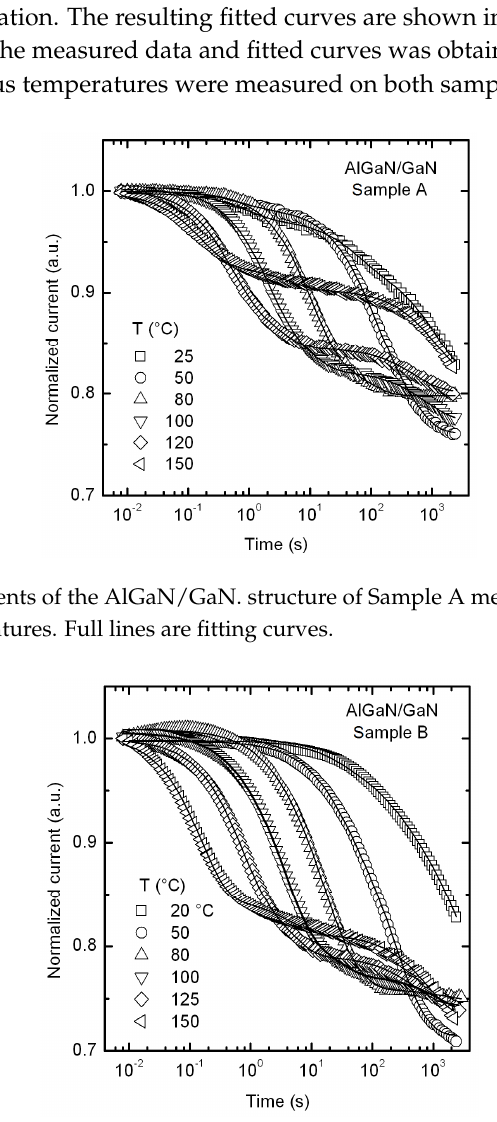
Figure 4. Current transients of the AlGaN/GaN structure. Sample B measured at a reverse bias of − 6 V at various temperatures. Full lines are fitting curves.